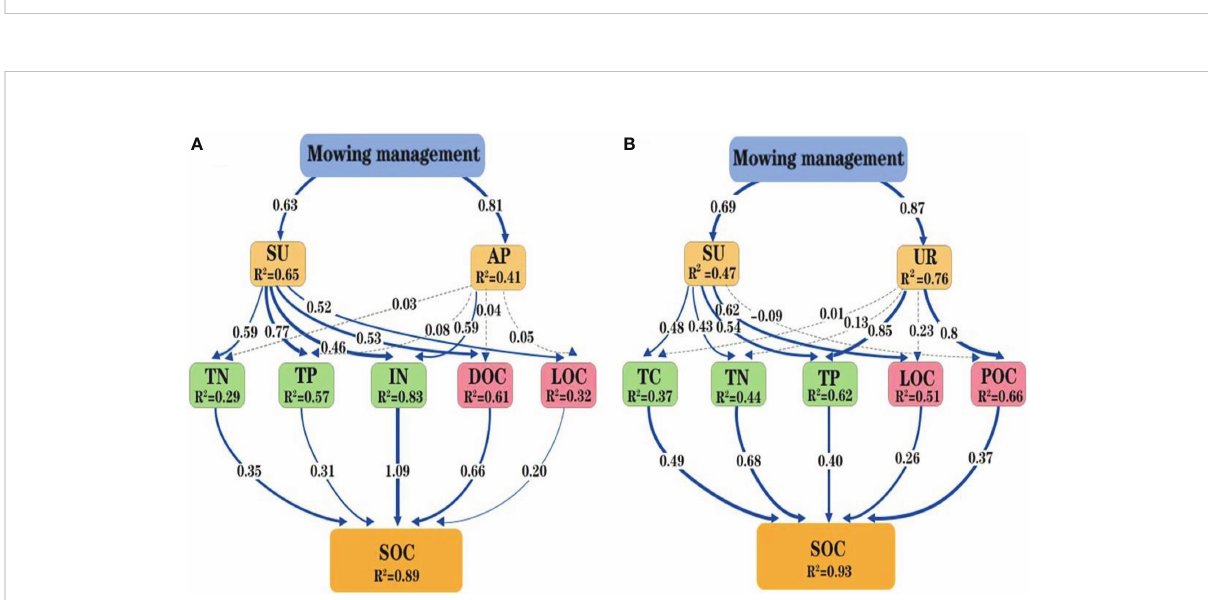
FIGURE 6 The structure equation model describes the plausible pathways by which mowing management treatment in fl uenced SOC content at 0 – 10 cm depth (A) and 10 – 20 cm depth (B) . Soil enzyme activities are shown in yellow, soil nutrients in green, SOC fractions in red, and SOC in orange. Blue solid arrows from thick to thin indicate positive pathways ( p < 0.001, p < 0.01, and p < 0.05), and light dashed gray arrows indicate non- signi fi cant relationships ( p > 0.05). The numbers next to arrows are standardized path coef fi cients, and the arrow width represents the strength of the relationship. The proportion of the variation (R 2 ) values occurs aside each response variable in the model. SU, sucrase activity; UR, urease activity; AP, alkaline phosphatase activity; TC, total carbon; TN, total nitrogen; TP, total phosphatase; IN, NH 4+ and NO 3 − ; DOC, dissolved organic carbon; LOC, labile organic carbon; POC, particulate organic carbon; SOC, soil organic